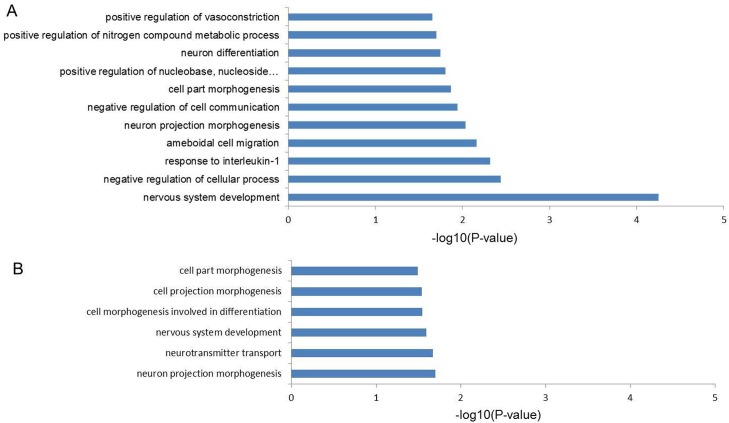
Gene ontology groups displaying the significant GO-terms of DMRs and DHMRs (p<0.05).(A)The significant GO-terms of DMRs between the groups. (B)The significant GO-terms of DHMRs between the groups.